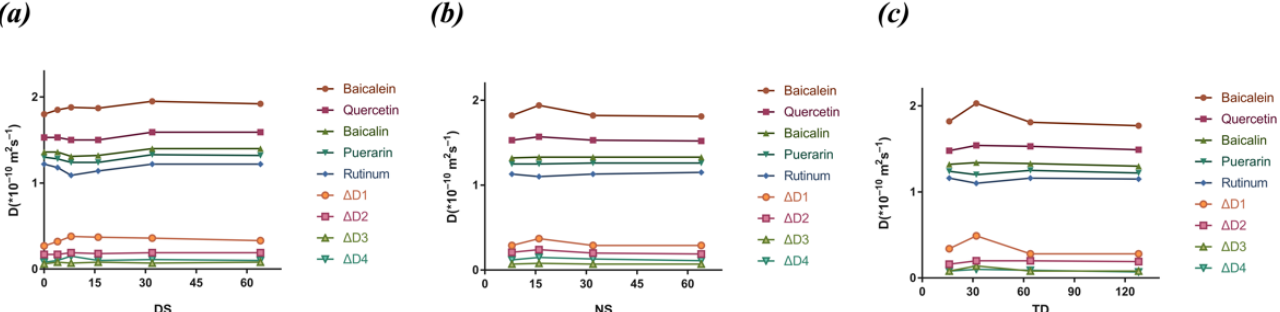
Figure 6. Effects of different DOSY NMR experimental parameters ( a ) with different DS values, ( b ) with different NS values, ( c ) with different TD values on the diffusion coefficient (D) and resolution (ΔD) of each analyte in the flavonoid mixture model.